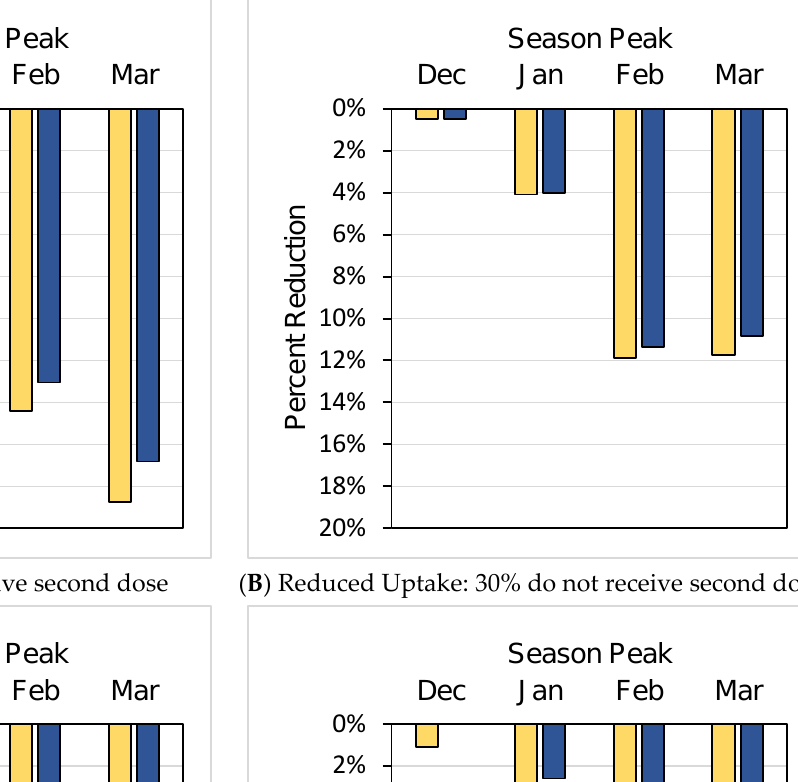
* Mean and 95% confidence interval over 100 simulations.